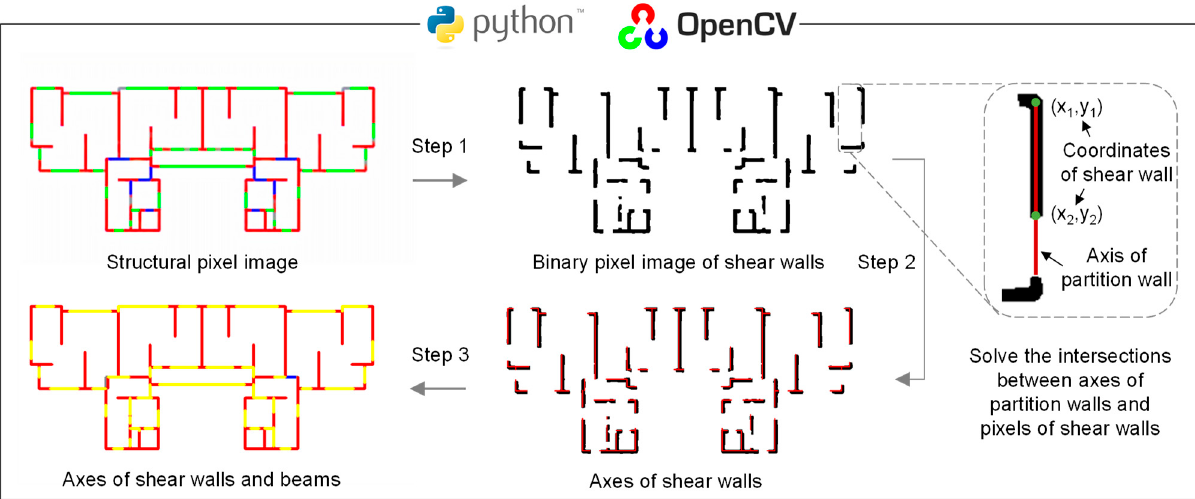
Figure 7. Heterogeneous data transformation.